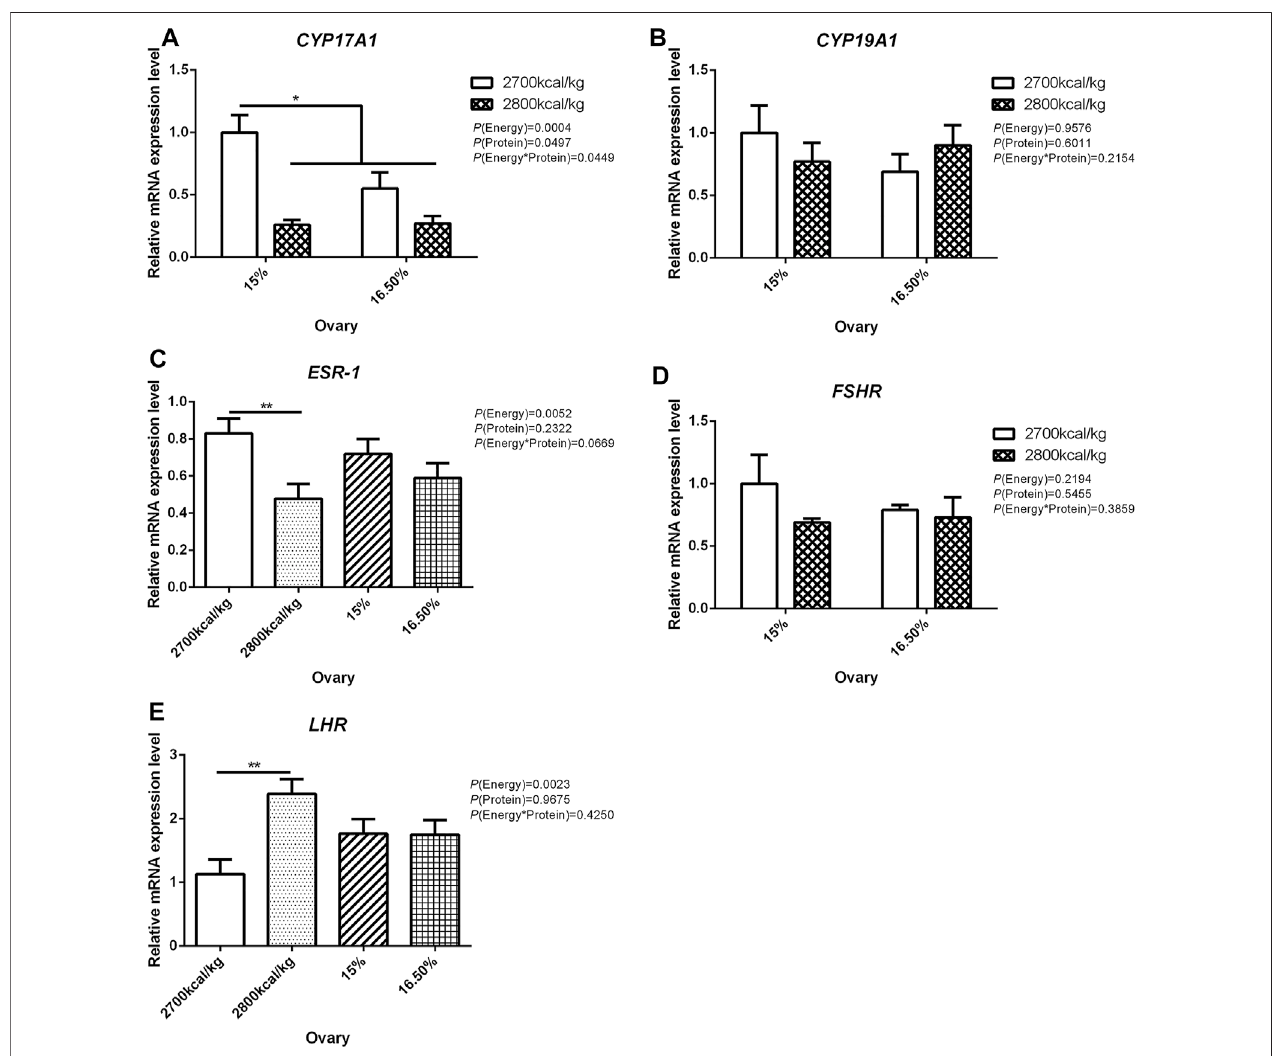
FIGURE3 | Effect of dietary metabolizable energy (E) and crude protein (P) levels during the prelay period (15 – 20 weeks of age) on themRNA expression of genes CYP17A1 (A) , CYP19A1 (B) , ESR-1 (C) , FSHR (D) , and LHR (E) in the ovary of hens. Data represent the mean ± SD ( n = 4); p p < 0.05, pp p < 0.01.